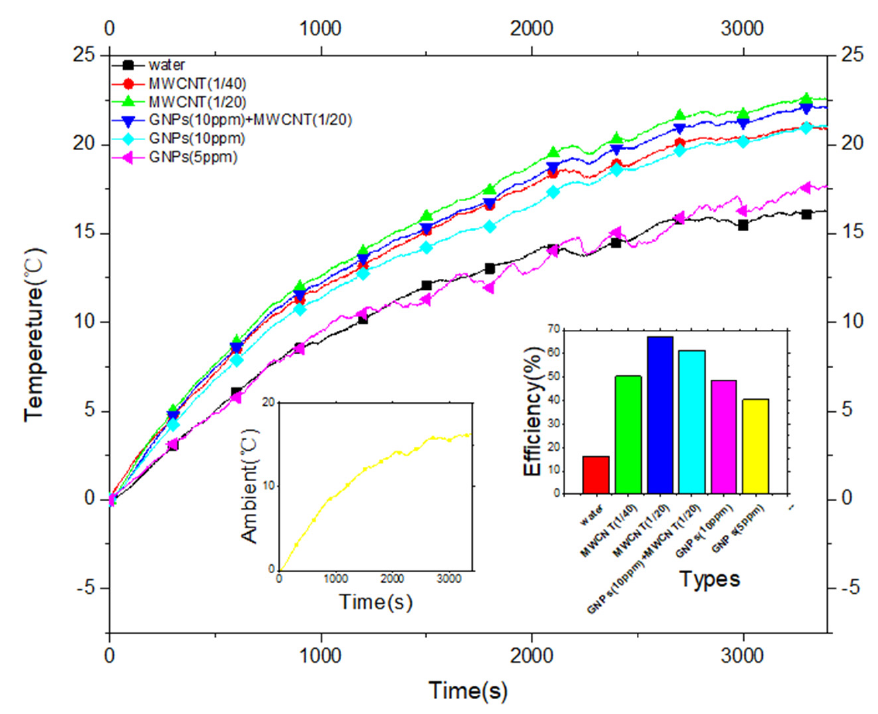
Figure 17. Predicted solar energy absorption efficiency and experimental results of Au-MWCNT hybrid nanofluid.